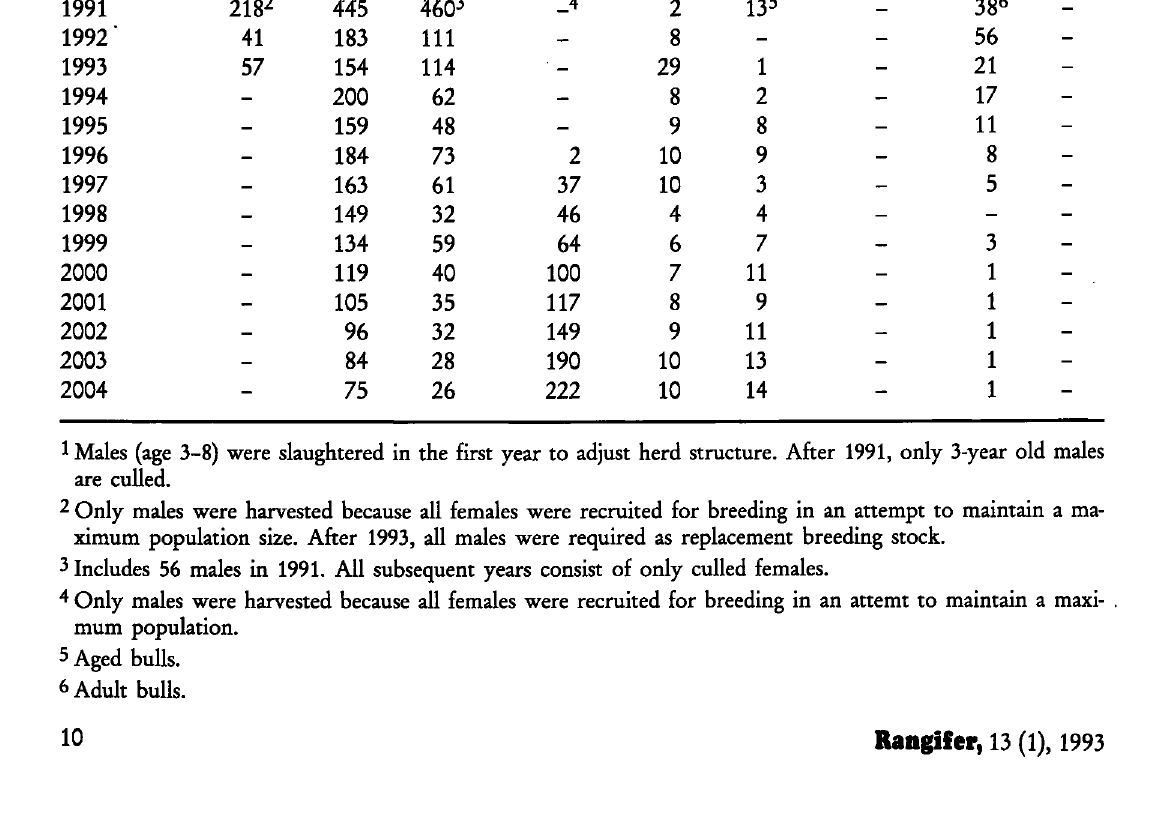
Table 3. Projected harvest of animals from three reindeer populations on the Seward Peninsula, Alaska, from